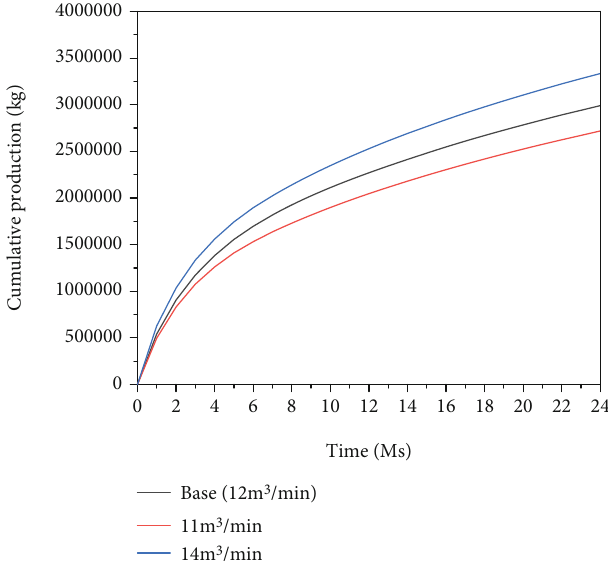
Figure 11: Cumulative oil production from horizontal wells with di ff erent fl uid injection rates.